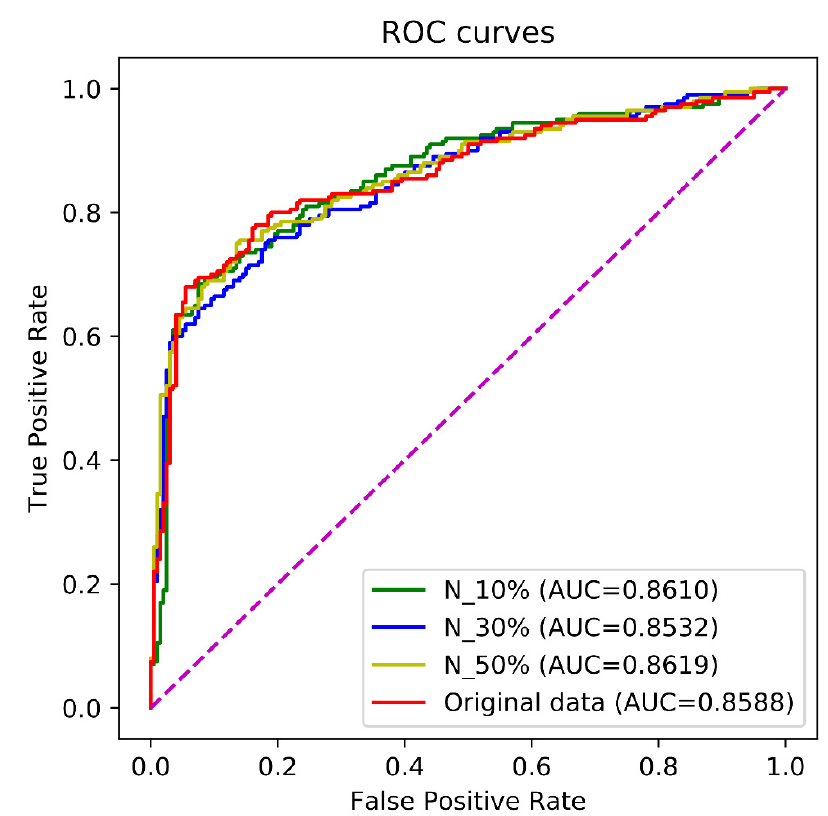
Figure 6. The ROC curves by the independent test over different non-enhancer sets. N_10, N_30, and N_50 denote the training sets in which 10%, 30%, 50% of non-enhancers were formed by mutation from the original non-enhancers, respectively. The original data denotes the training set which was made up of the enhancers and original non-enhancers. The purple line is the baseline of ROC curve, named random guessing line.